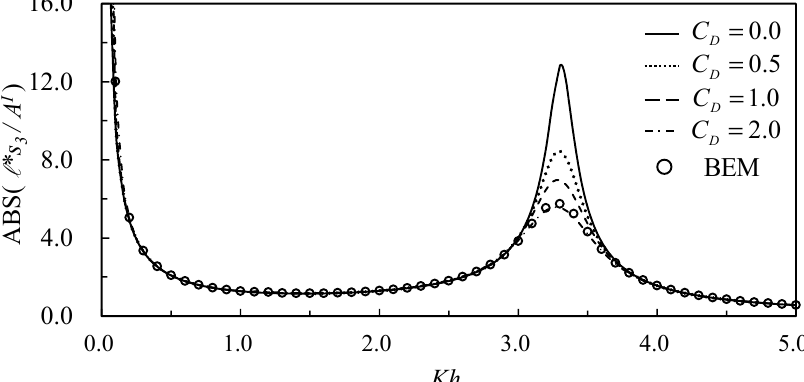
Figure 10. Heave motion amplitude versus relative water depth for various drag coefficients ( d 1 / h = 0.25, (cid:96) / h = 0.2, a / h = 0.3, and C M = 2.0).